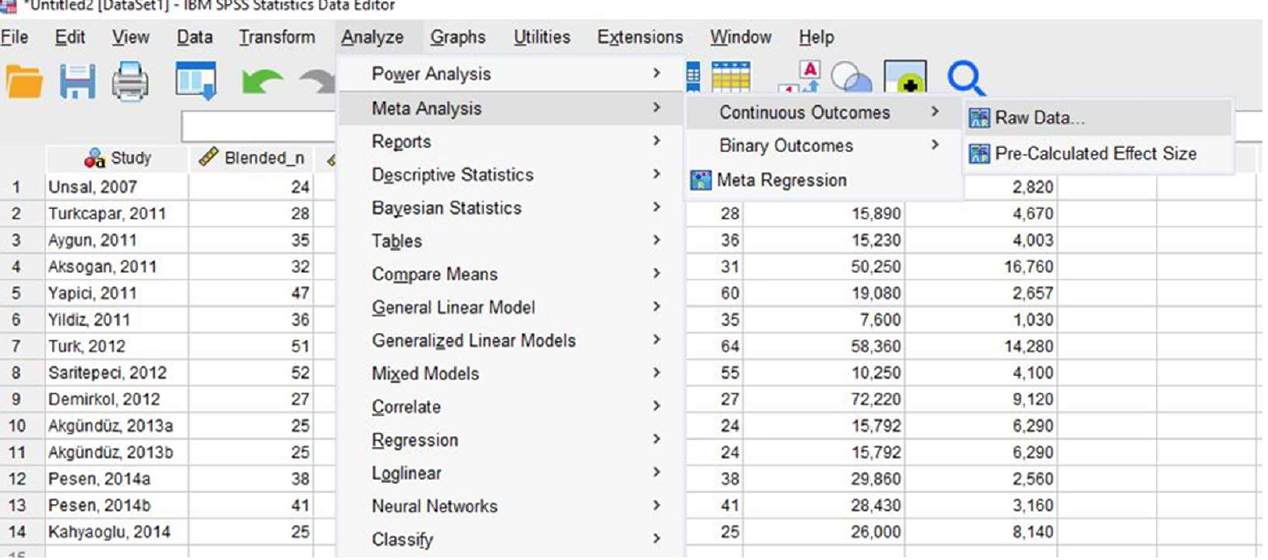
Figure 4. Meta-analysis with Raw Data.